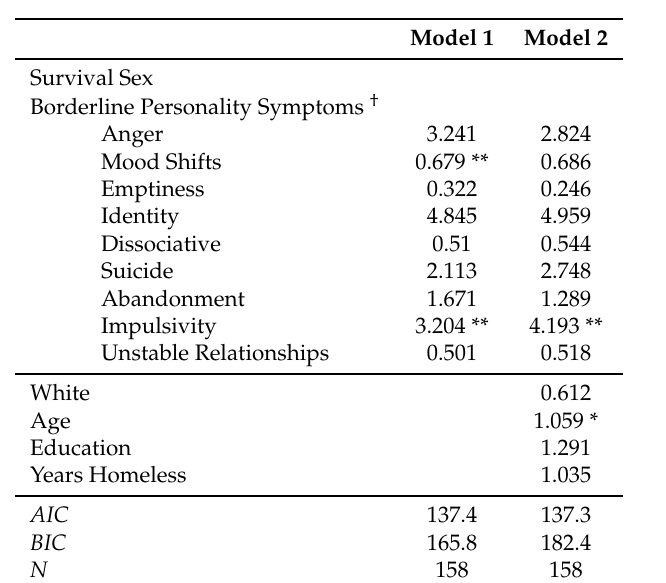
Table 3. Logistic regression models of borderline personality disorder (BPD) symptoms on survival